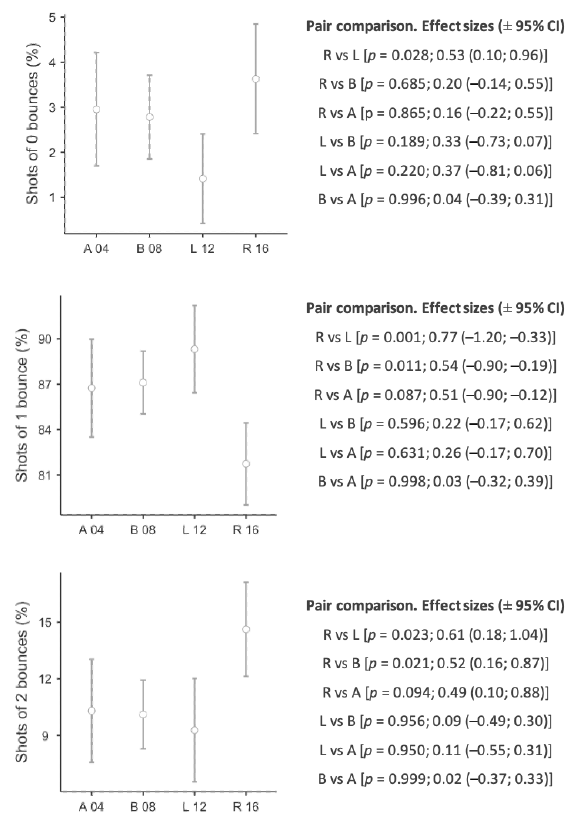
Figure 3. Differences comparing Paralympic Games in shots after zero, one or two bounces. Lines denote mean (95 CI). Pair Paralympic Games comparison (A 04: Athens 2004; B 08: Beijing 2008; L 12: London 2012; R 16: Rio 2016) on p value and effect sizes (±95% CI).